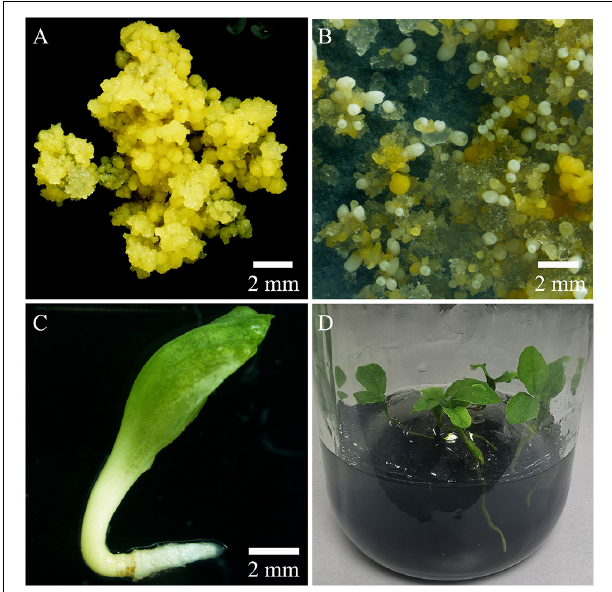
FIGURE 6 | Production of tetraploid plantlets by somatic embryogenesis. (A) Tetraploid embryogenic cell line of Magnolia officinalis . (B) Somatic embryo differentiation from tetraploid ECAs plated on a piece of filter paper and cultured on M4 medium for 6 weeks. (C) Tetraploid somatic embryo germinating on M4 medium. (D) Conversion of tetraploid somatic embryos into